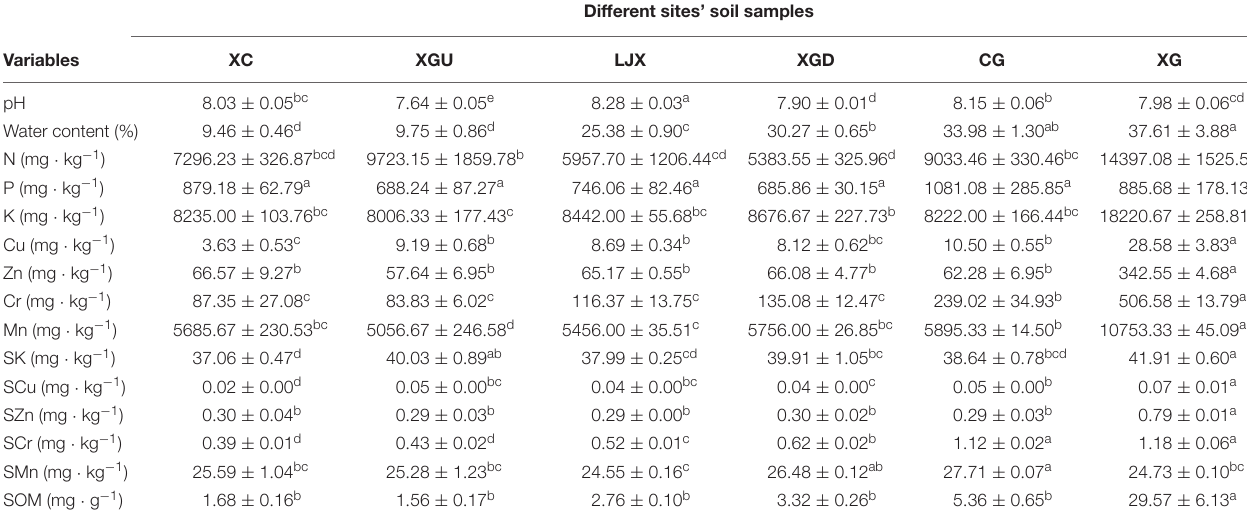
TABLE 1 | Physicochemical properties of the sites’ soil samples.